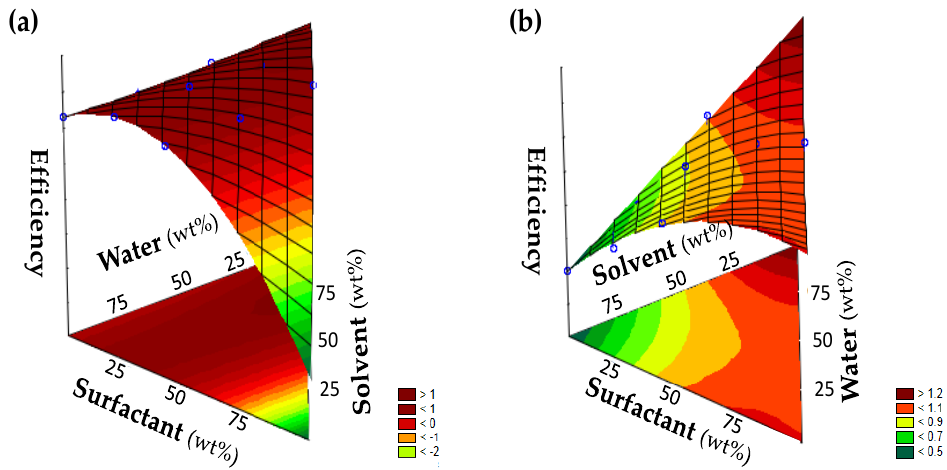
Figure 8. Response surface of cleaning efficiency for ( a ) ceramic and ( b ) stainless steel as a function of the composition of the ternary mixture in weight percentage (IPG (solvent), C 11 –C 13 9EOs (surfactant), and water).